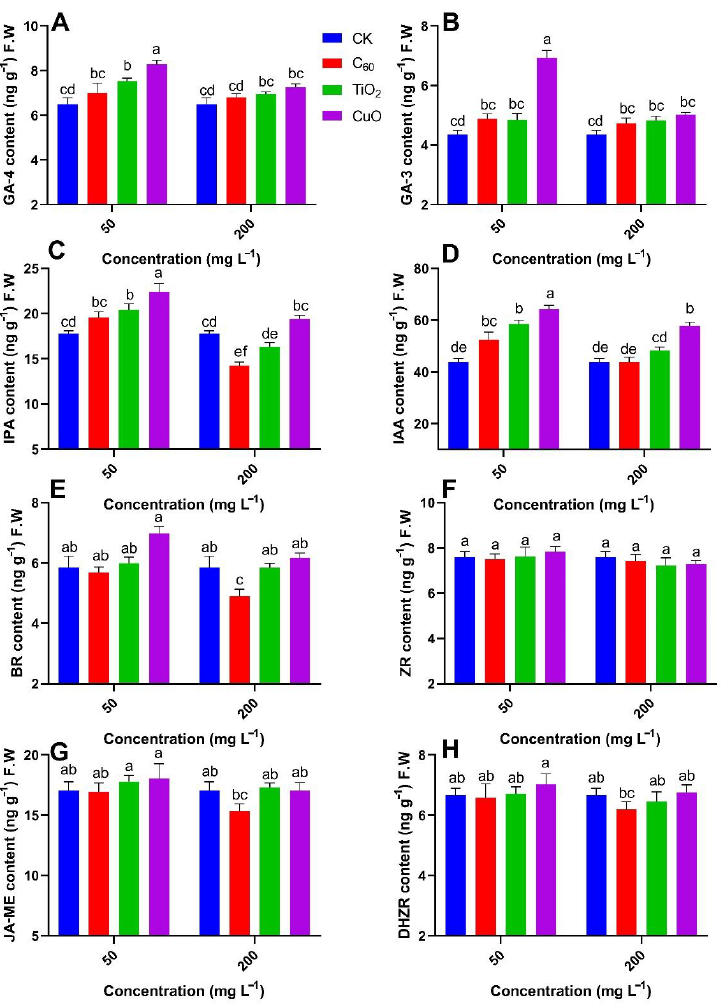
Figure 6. Effect of different NMs on the mean contents (n = 3) of ( A ) gibberellic acid-4, ( B ) gibberellic acid-3, ( C ) indolepropionic acid, ( D ) indole-3-acetic acid, ( E ) brassinolide, ( F ) zeatin riboside, ( G ) methyl jasmonate, and ( H ) dihydrozeatin riboside hormones in sweet potato cultivar (J26) exposed to soft rot disease. Different small letters represent significant difference according to Duncan’s multiple range test ( p < 0.05. n = 3).